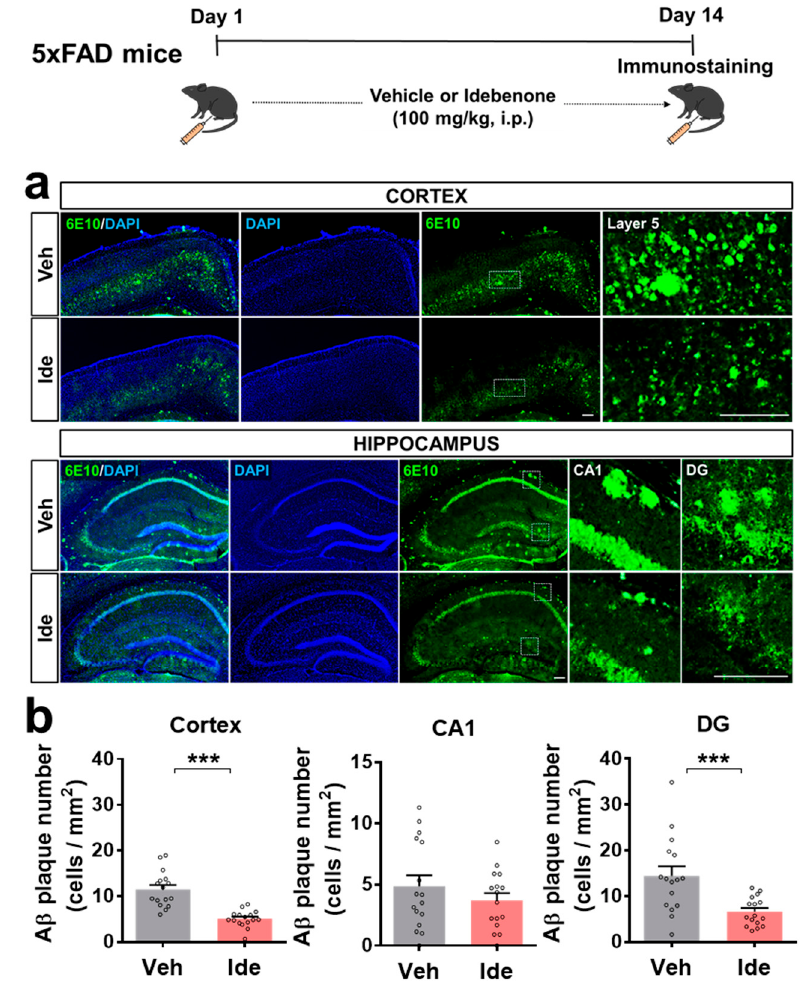
Figure 1. Idebenone significantly decreases A β pathology in a mouse model of AD. ( a ) Representative images of cortical and hippocampal 6E10 immunofluorescent staining. Idebenone or vehicle was administered daily to 3-month-old mice for 14 consecutive days, as shown at the top of the figure. Immunostaining of brain sections with anti-6E10 was subsequently performed. ( b ) Quantification of the results (n = 16 brain slices from four mice/group). *** p < 0.001 vs. vehicle-treated control. Scale bar = 200 µm.